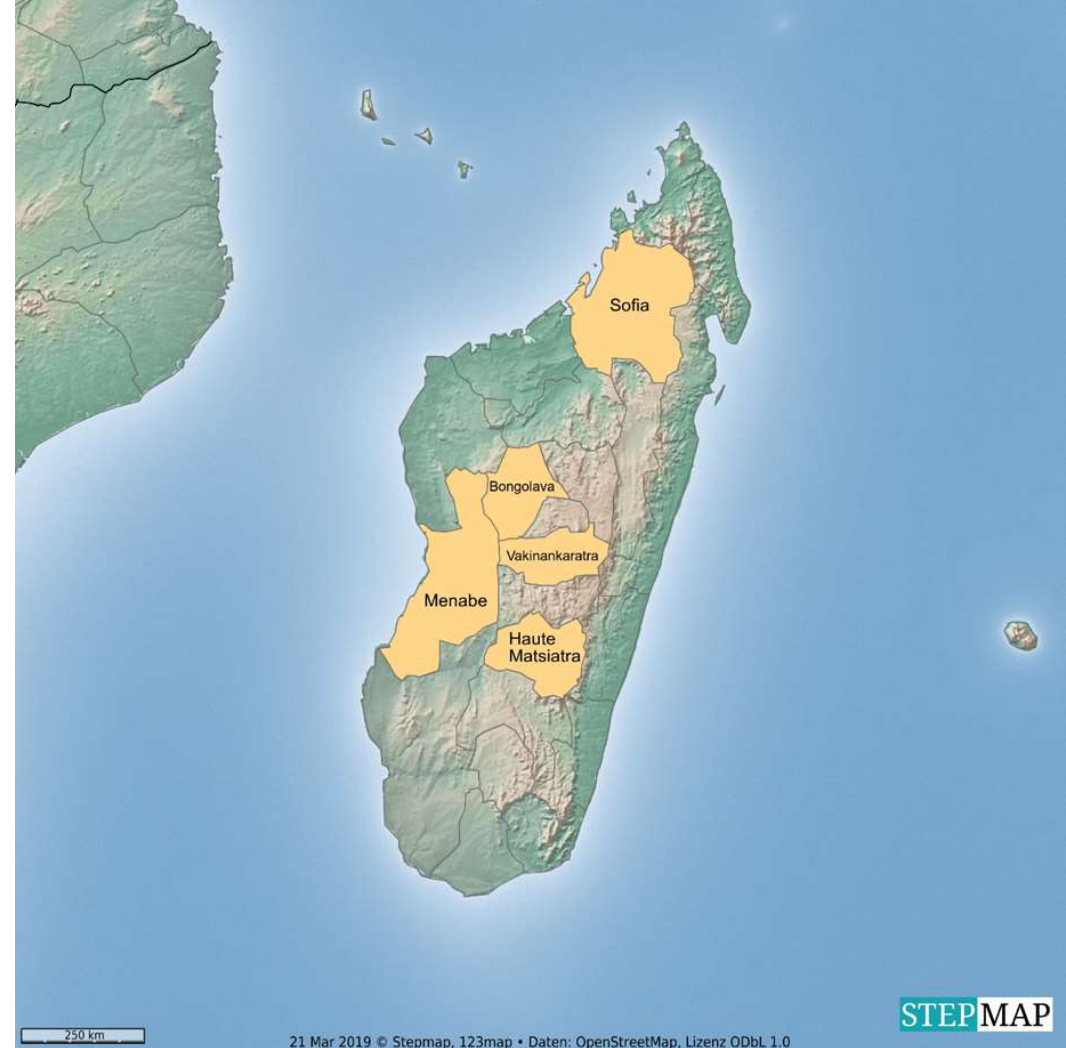
Figure 1. Origin of Malagasy zebu sera.